Question: Generate an informative caption for the figure above.
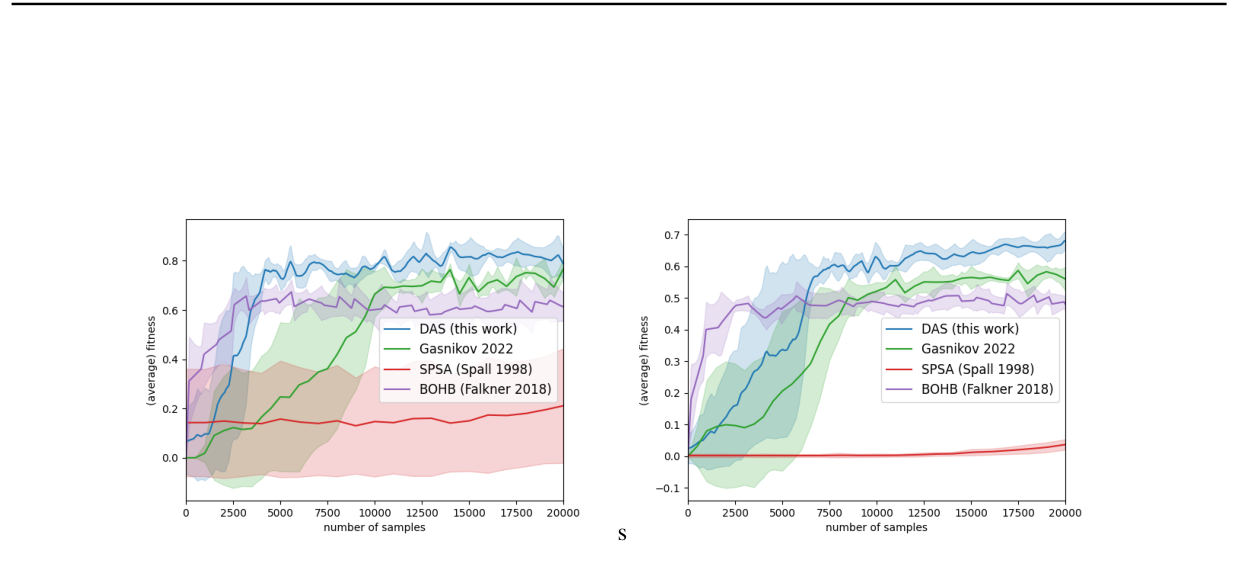
Answer: Average fitness (soft success rate) obtained by different tuning methods on random SK model instance with, N = 150, βE = 0.01 (left) and N = 300, βE = 0.005 (right). The fitness function is defined by equation (52). Averages are over 5 realizations of the tuning dynamics starting at different randomized positions. The shaded region represents one standard deviation of the data. To evaluate the fitness for each parameter configuration, 20 random SK instances are generated, and 50 trajectories are evaluated for each. The left plot of this figure is identical to the right plot of 3 of the main text but is included here as well for completeness.